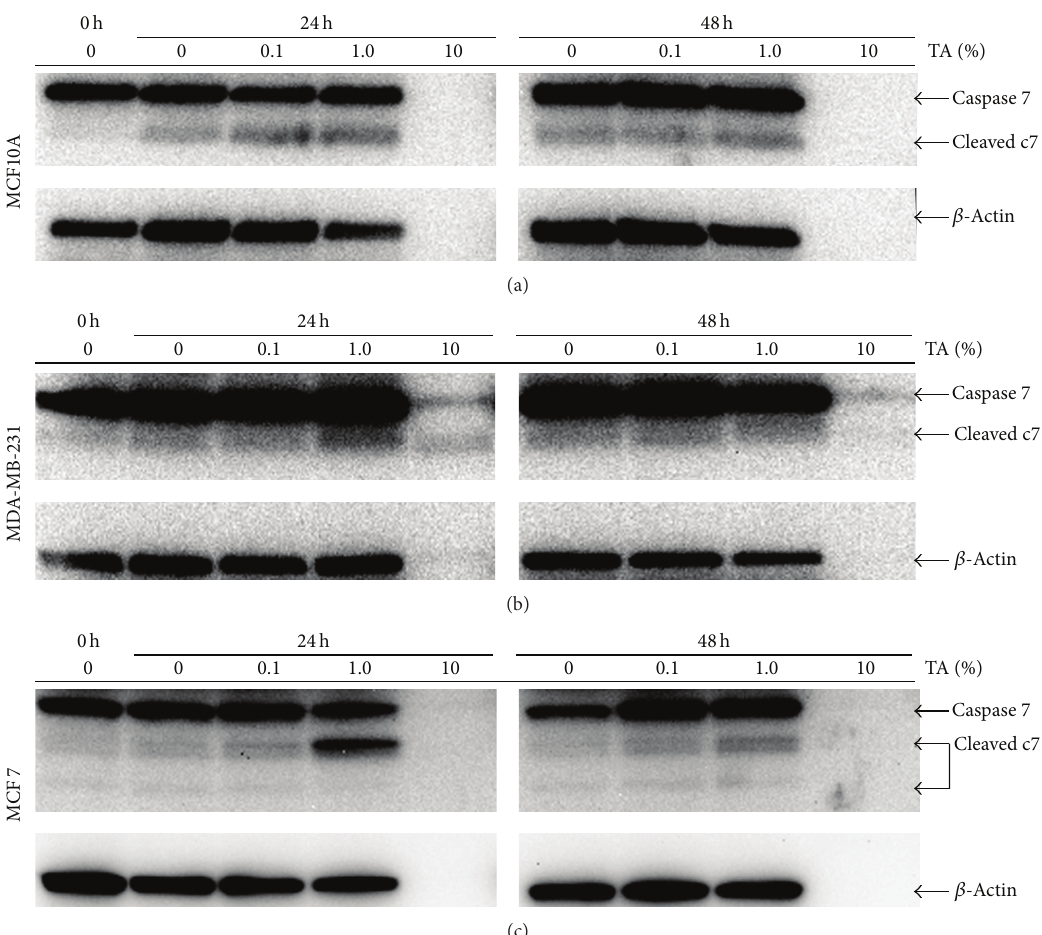
Figure 6: Analysis of caspase 7 in TA-treated breast cells. (a) MCF10A, (b) MDA-MB-231, and (c) MCF7 cells were exposed to TA-crosslinked beads of varying concentrations for the time indicated. Western analysis of collected cell lysates indicated that caspase 7 is activated, as evidenced by the presence of cleaved caspase 7. Increased cleaved caspase 7 is observed in lysates collected from MCF7 cells. 𝛽 -Actin was used as a loading